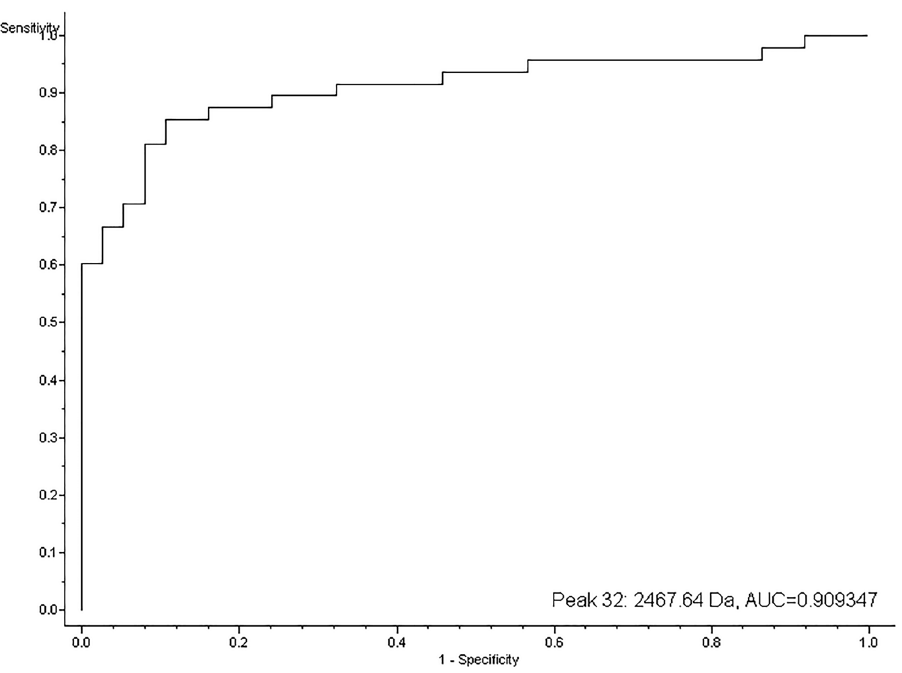
Figure 2. Receiver operating characteristic (ROC) curve representing sensitivity and specificity of peak of m/z 2467.64. Area under the ROC curve (AUC) is